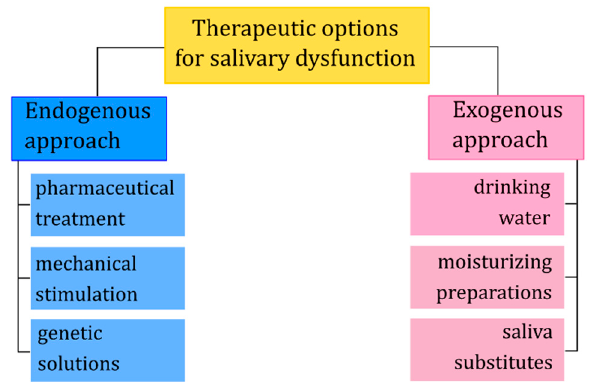
Figure 2. Therapeutic options for salivary dysfunction.